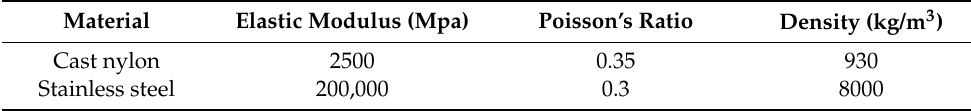
Table 5. Material parameters of different sensor packaging